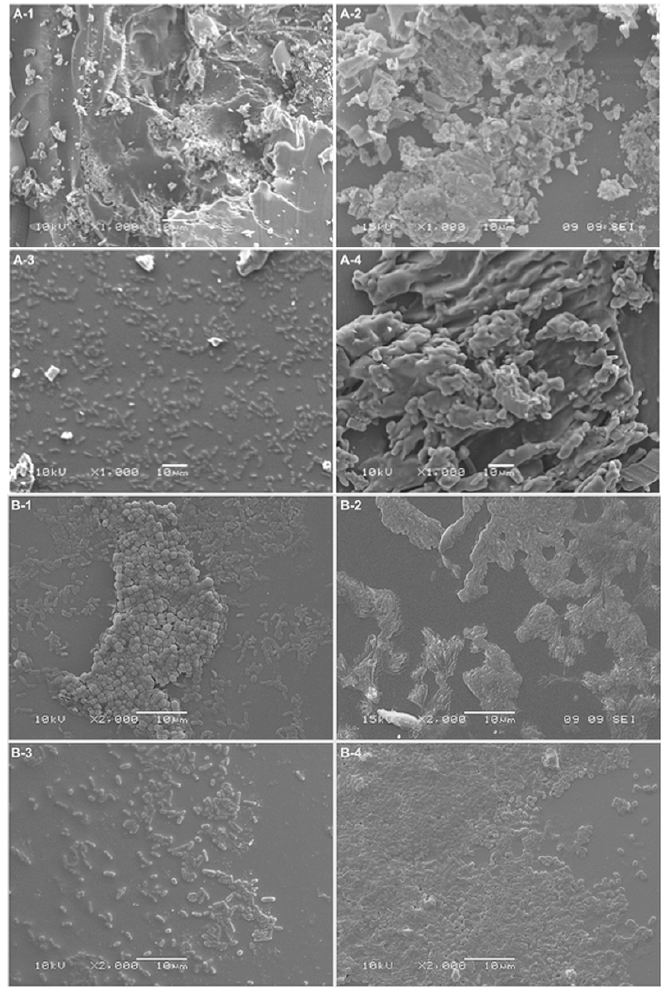
Figure 7. Bacterial attachment observed by SEM: ( A ) A. hydrophila biofilms; ( B ) C. freundii biofilms; (1) control; (2) NAC eradication; (3) NAC-Si-1 eradication; (4) NAC-Si-2 eradication (scaling bar: 10 μ m).